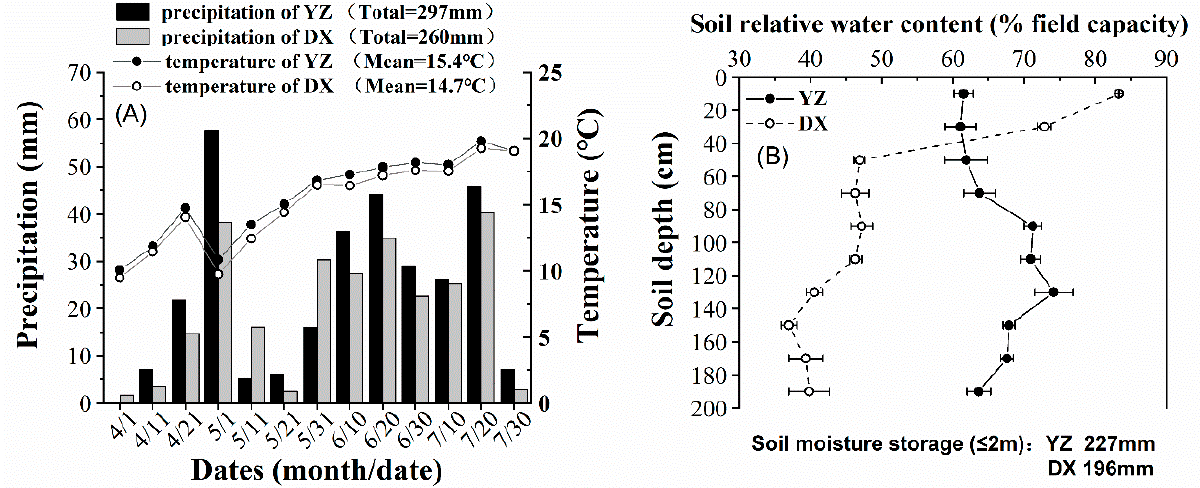
Figure 1. ( A ) Cumulative 10-day precipitation and mean 10-day air temperature during the growth period of wheat (April–July 2019) at Yuzhong (YZ) and Dingxi (DX). The date in the x-axis is the first day of the 10-day periods.; ( B ) Soil relative water content as a percentage of the field capacity of the upper 2 m of the soil profile at YZ and DX just prior to sowing.